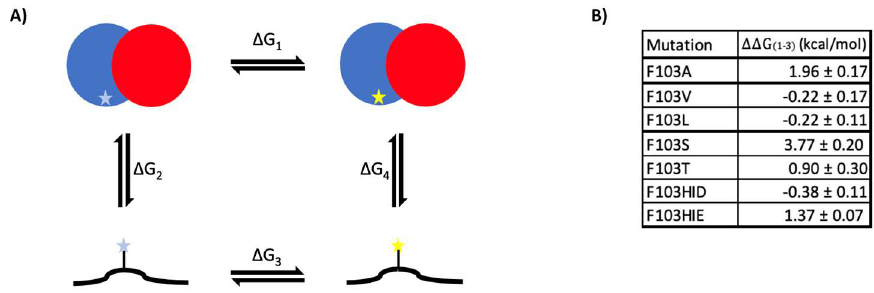
Figure 4. Free energy determination of F103 α mutants. ( A ) Stability of LigAB was determined through determination of free energy differences between wild-type and mutant heterodimer of LigAB in folded and unfolded state based on the thermodynamic cycle, where ∆∆ G 1–3 is the free energy of the mutation. ( B ) The hydrophobic mutations (valine, leucine) are stabilizing relative to the wild-type, while polar and highly flexible mutations are strongly destabilizing (alanine, serine, histidine, threonine).